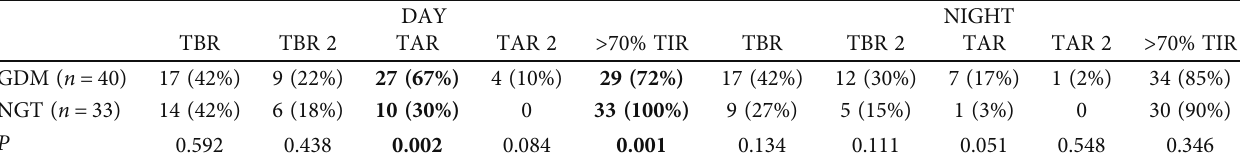
Table 4: Comparison of the number of patients with values below and above the range and with 70% of time in range over day and night among the total of the GDM and NGT groups.